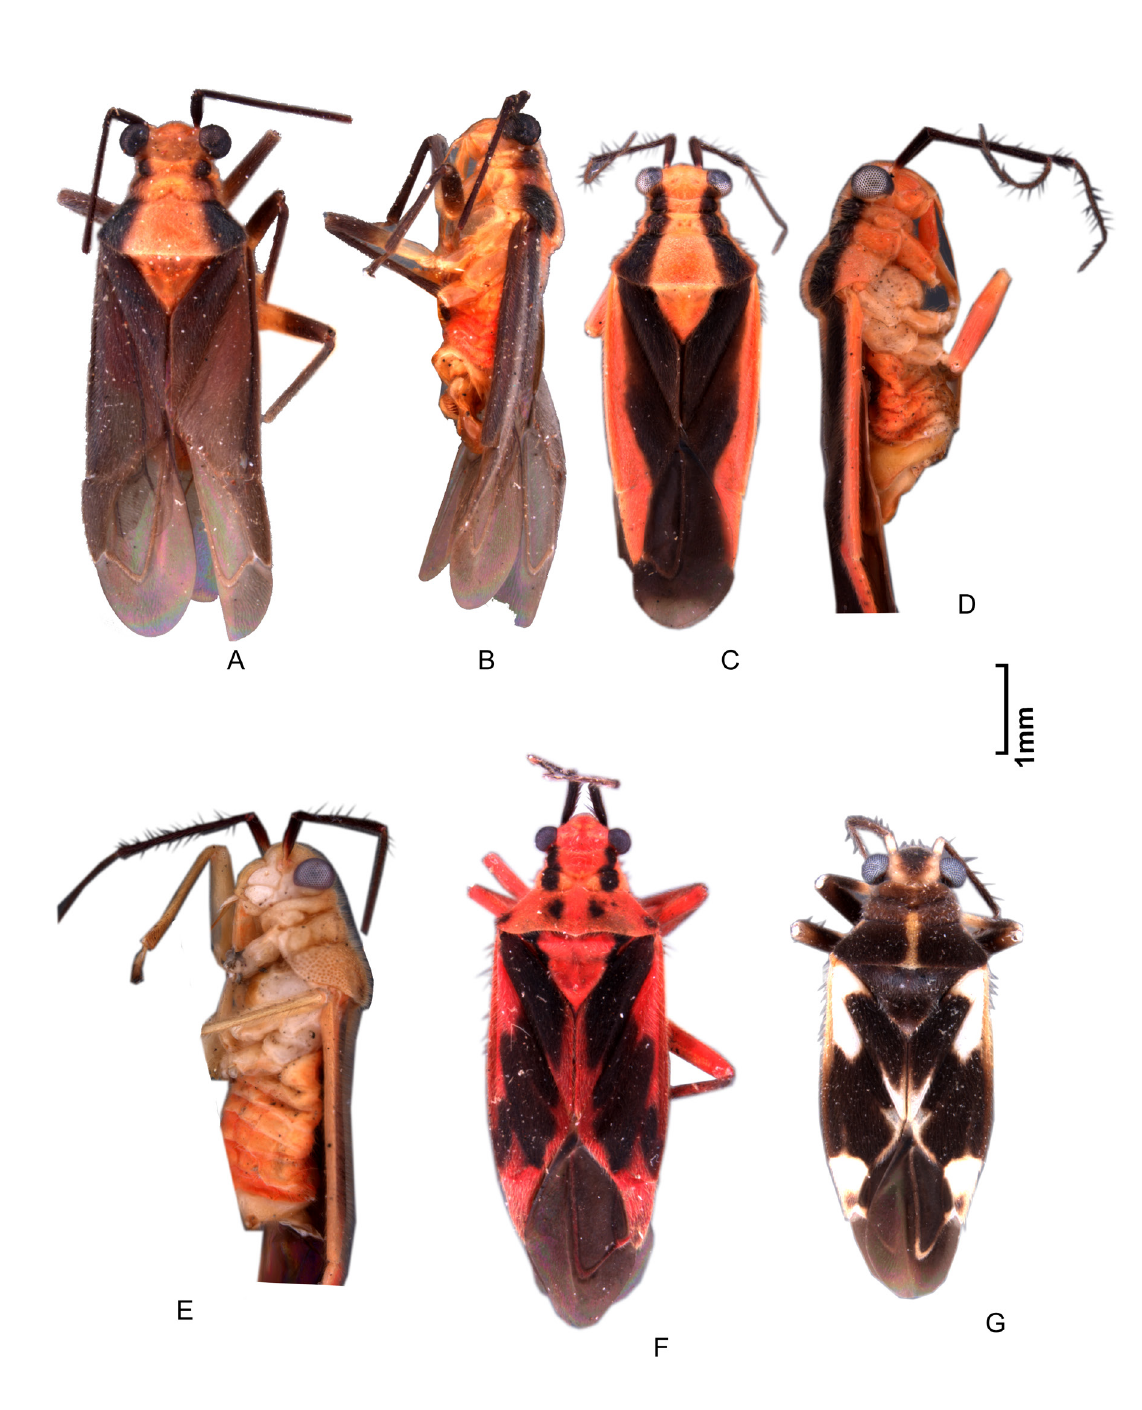
Fig. 7. Habitus of Lopidolon type specimens. A–B . Lopidolon dissimilis (Hsiao, 1944) comb. nov. , ♂, holotype in dorsal and lateral view, USNM. C–D . Lopidolon marginatus (Hsiao, 1944) comb. nov . , ♀, holotype in dorsal and lateral view, USNM. E . Lopidolon puncticollis (Hsiao, 1944) comb. nov., ♂, holotype in lateral view, USNM. F . Lopidolon nigripictus (Hsiao, 1944) comb. nov., ♀, holotype in dorsal view, USNM . G . Lopidolon viridipictus (Hsiao, 1944) comb. nov., ♂, holotype in dorsal view, USNM